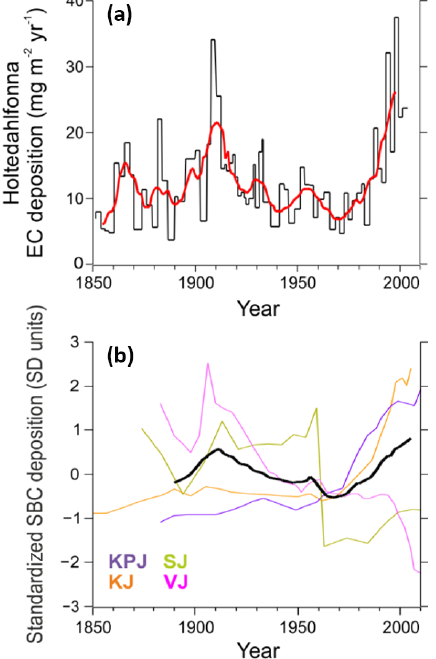
Figure 15. BC deposition at a Svalbard glacier and four north- ern Finland lakes between 1850 and 2010. (a) EC deposition at Holtedahlfonna and a 10-year running average (red line). (b) Stacked SBC deposition at four northern Finland lakes (KPJ, KJ, SJ, and VJ) expressed as standard deviations from the mean. The black curve indicates a LOESS smoother (span of 0.15) of time intervals from which data are available from all the lakes. Adapted with permission from Ruppel et al. (2015). ©2015, Amer- ican Chemical